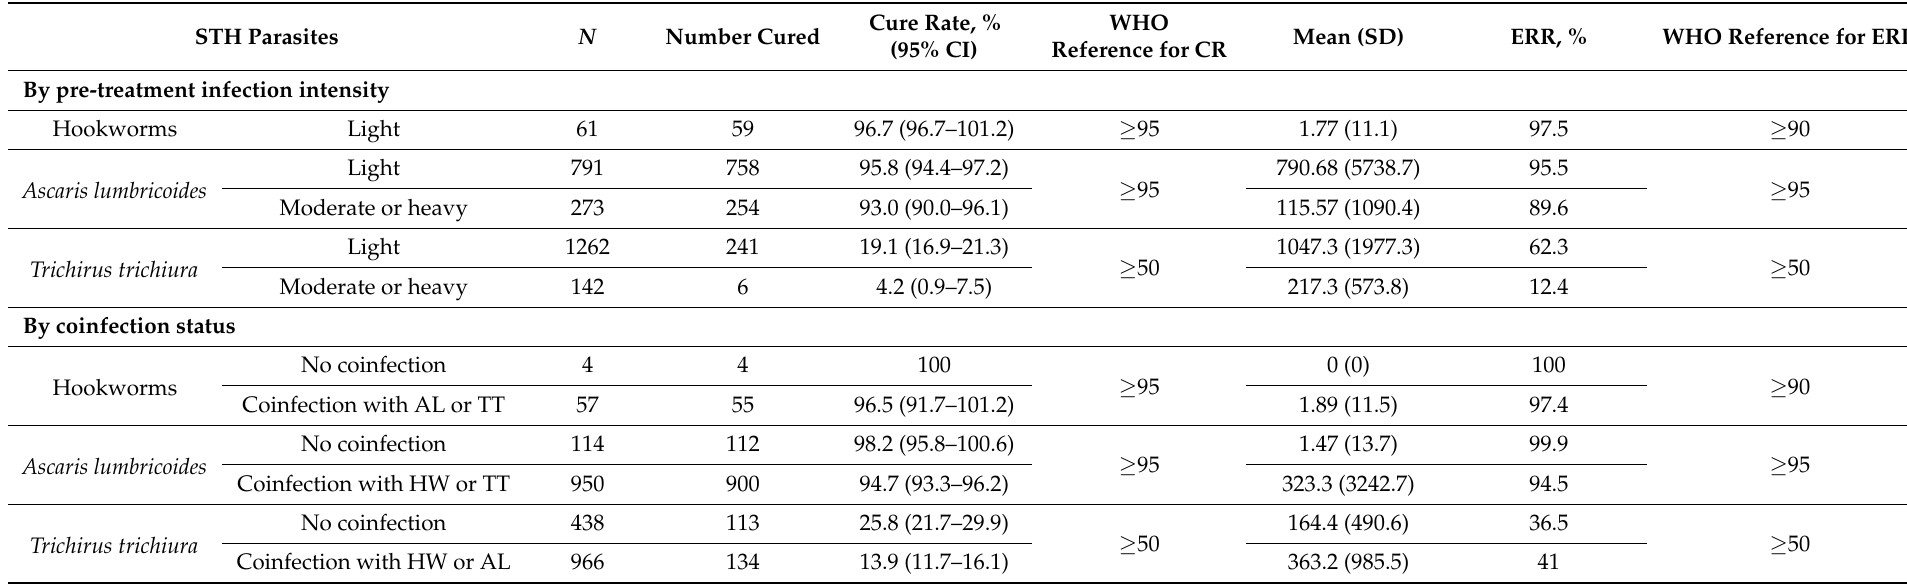
Table 3. Cure rate and egg reduction rate stratified by pre-treatment infection intensity and by status of coinfection with other type of STH parasites. STH Parasites N Number Cured